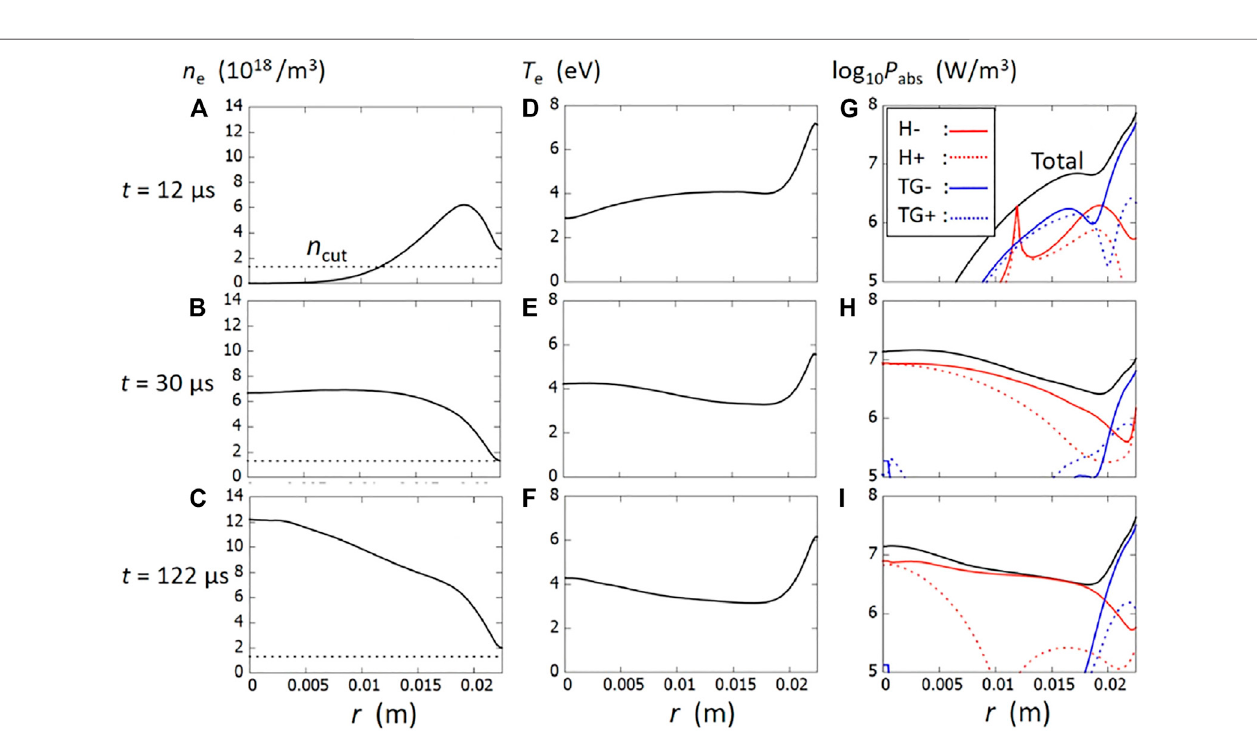
FIGURE 5 | Computed pro fi les of electron density (A – C) , electron temperature (D – F) and power absorption (G – I) at t (cid:3) 12 μ s, t (cid:3) 30 μ s, and t (cid:3) 122 μ s. Reproduced from [36], with the permission of AIP Publishing.